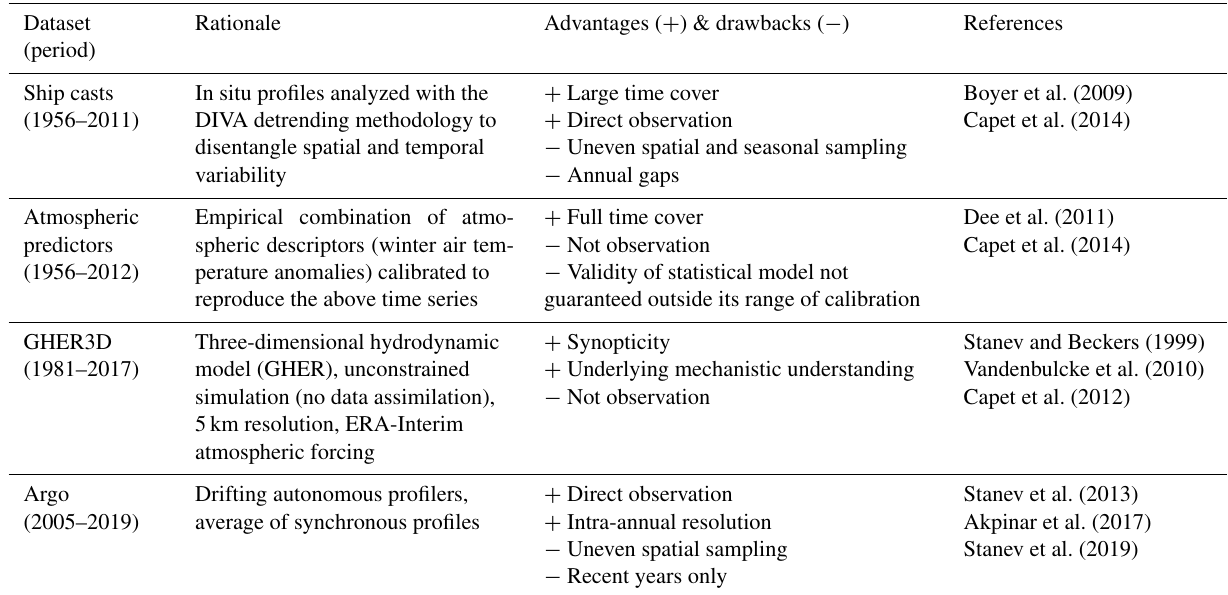
Table 1. Overview of the four datasets used to characterize the CIL inter-annual variability. Details are provided for each dataset in Sect.